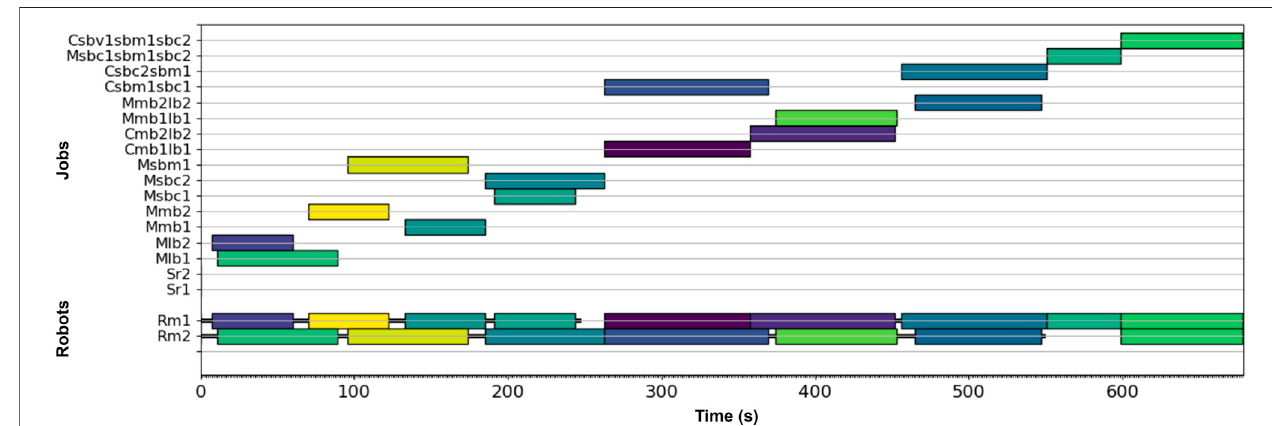
FIGURE4| Optimalschedulegeneratedbythemixedintegerprogram.Thebottomportionofthegraphshowstherobottotaskallocationandtheupperportionof the graph shows the task sequencing. The job times between the two portions are color coded and spatially synced.